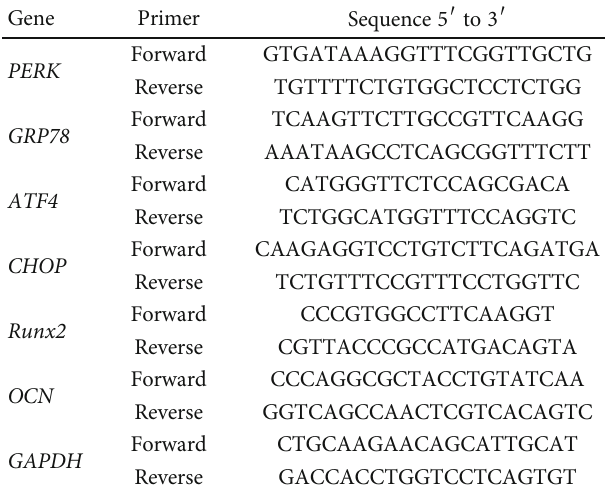
Table 1: Primer sequence used for